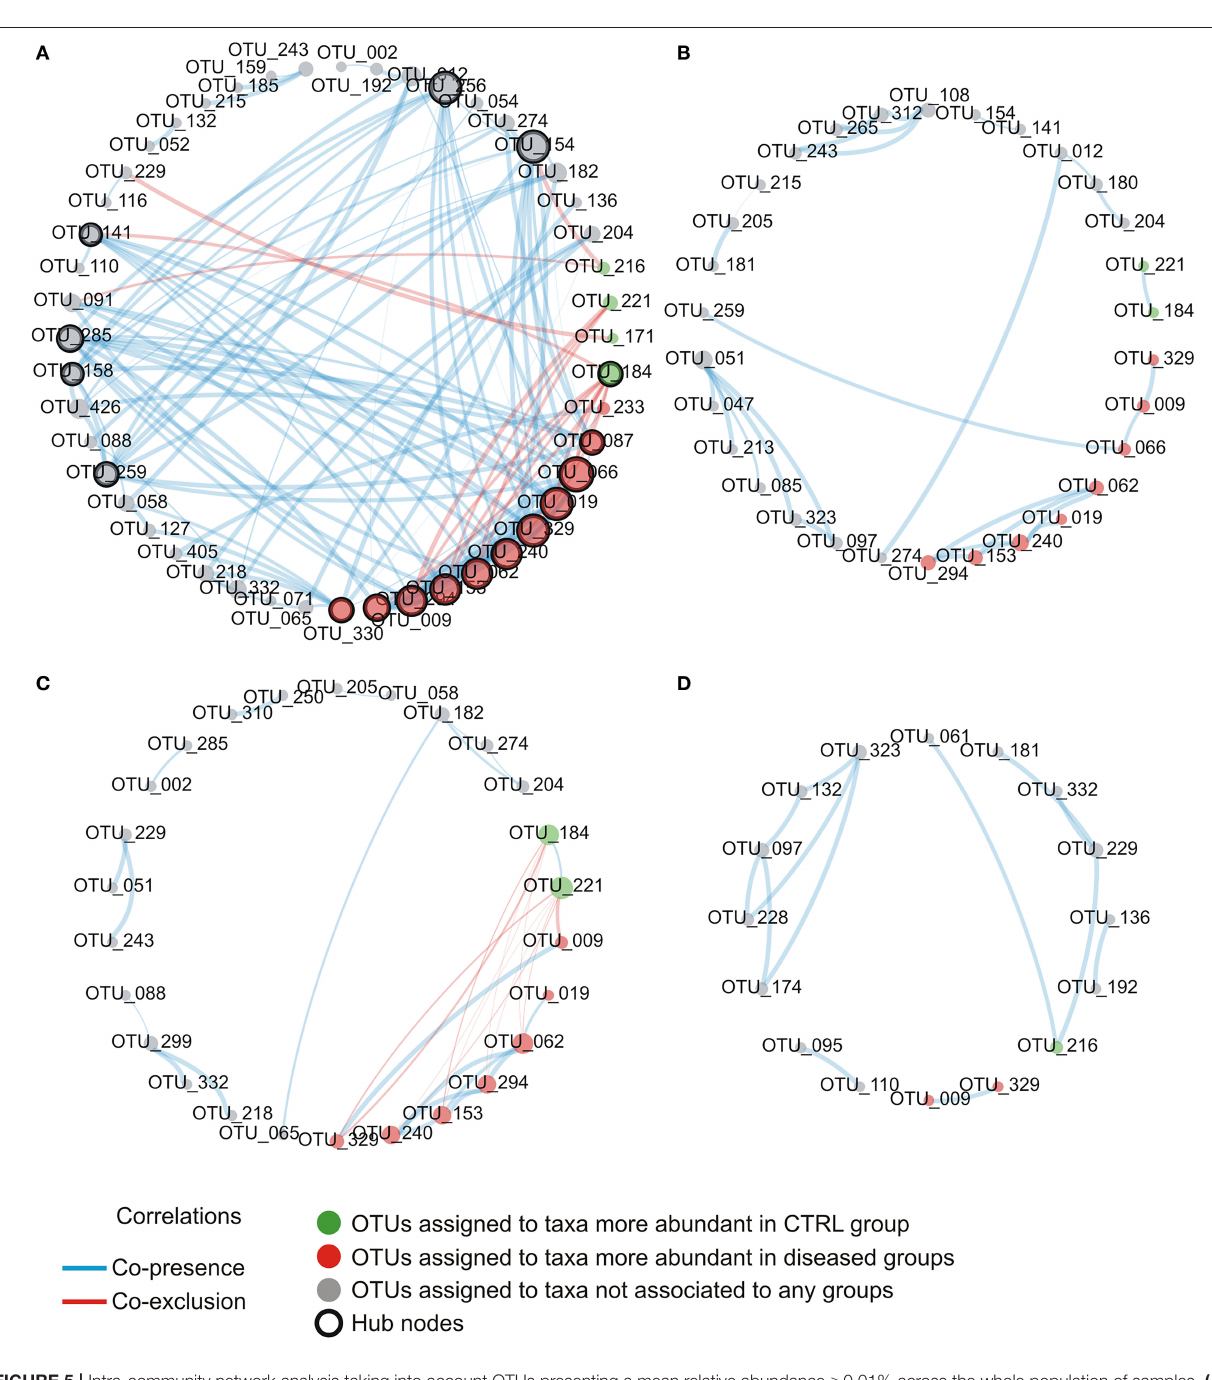
FIGURE 5 | Intra-community network analysis taking into account OTUs presenting a mean relative abundance ≥ 0.01% across the whole population of samples. (A) CTRL, (B) AH, (C) AR, (D) AH + AR. The size of each node is proportional to the number of edges departing from it while the edge thickness is proportional to the strength of